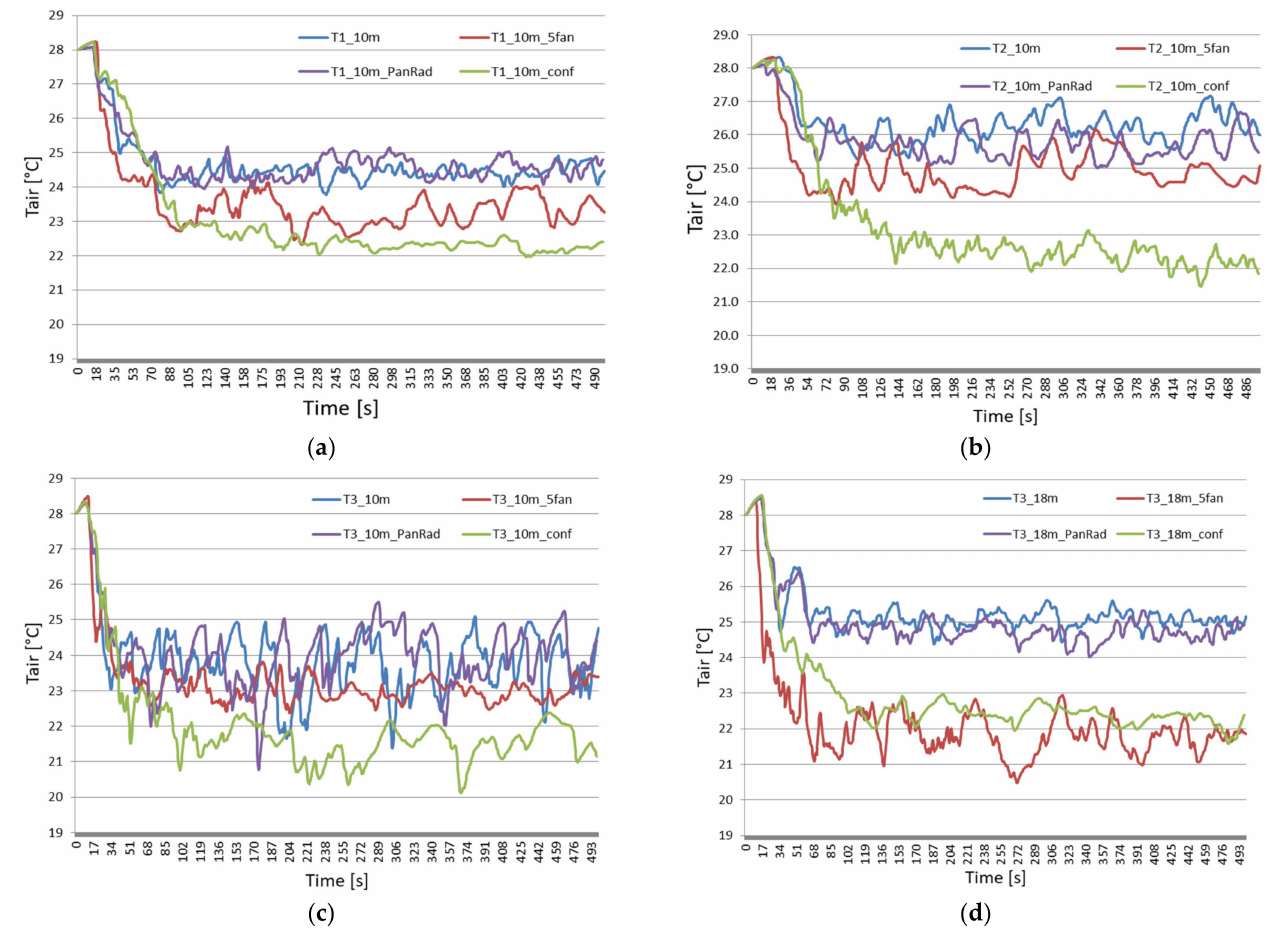
Figure 18. Simulated air temperatures trends for the control points T1_10 m ( a ), T2_10 m ( b ), T3_10 m ( c ), T3_18 m, ( d ) (see the Table 1 for the